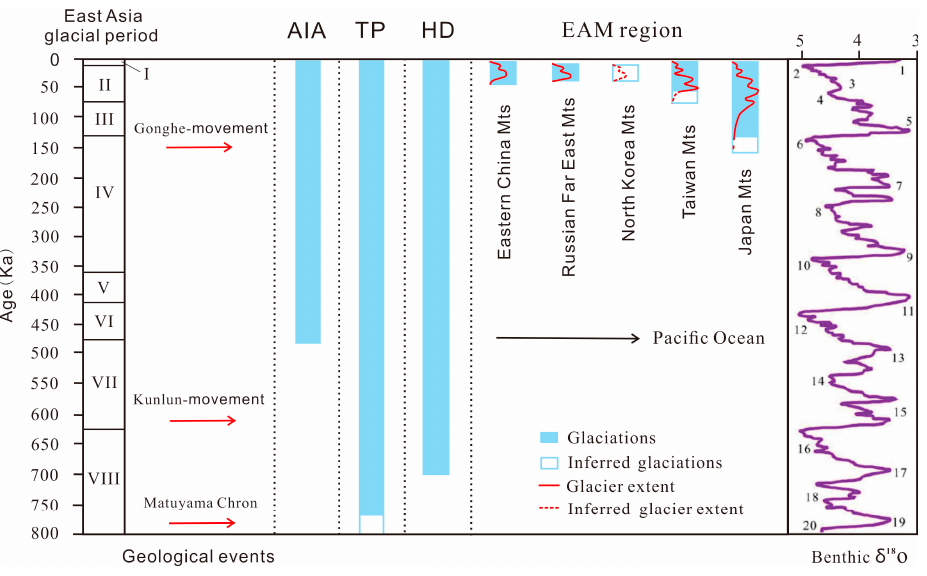
Figure 3. Comparison of mountains glacial period between EAM region and adjacent areas. Data reference from [9,13,78]. Benthic δ 18 O curve reference from [79], numbers represent the marine isotope stages. I: Holocene; II: Last Glacial Period; III: Last Interglacial; IV: Penultimate Glaciation; V: Penultimate Interglacial; VI: Zhonglianggan Glaciation; VII: Great Interglacial; VIII: Wangkun Glaciation. AIA: Asia Inland area; TP: Tibet Plateau; HD: Hengduan Mountains, see Figure 1 for geographical